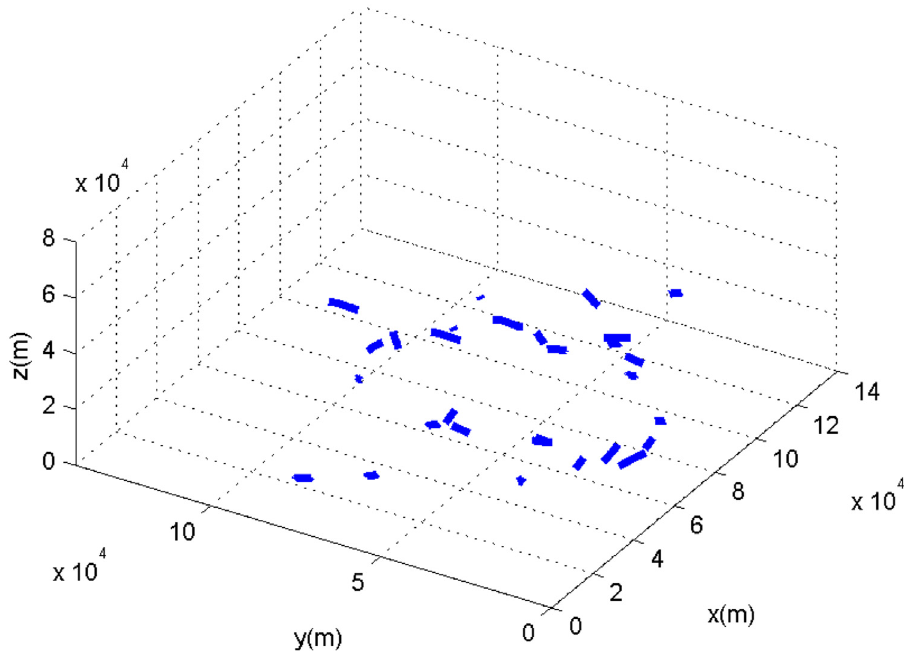
Fig 6. The target tracks with 30